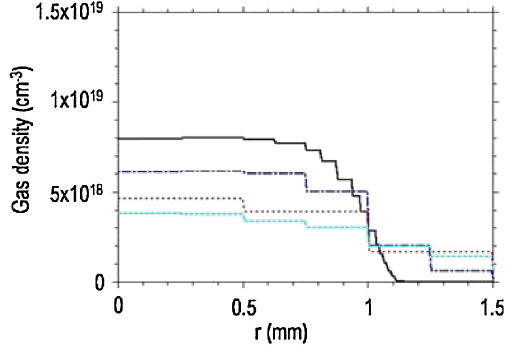
FIG. 6. 4.6 mm straight nozzle radial density lineouts for 0 (black), 1 (blue), 2 (red), and 3 (teal) mm downstream of the nozzle exit at 10 (cid:1) s .